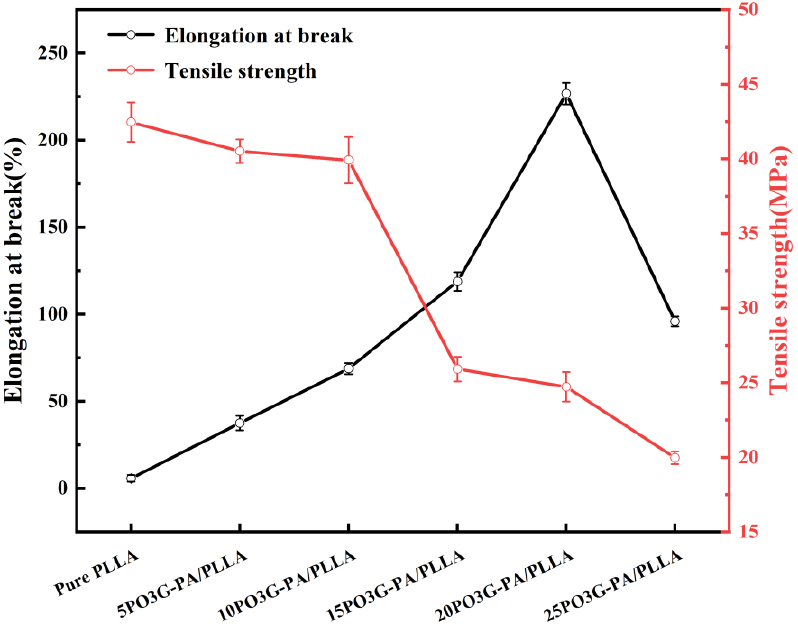
Figure 8. Elongation at break (black) and tensile strength (red) of PO3G–PA/PLLA composite films with different ratios.